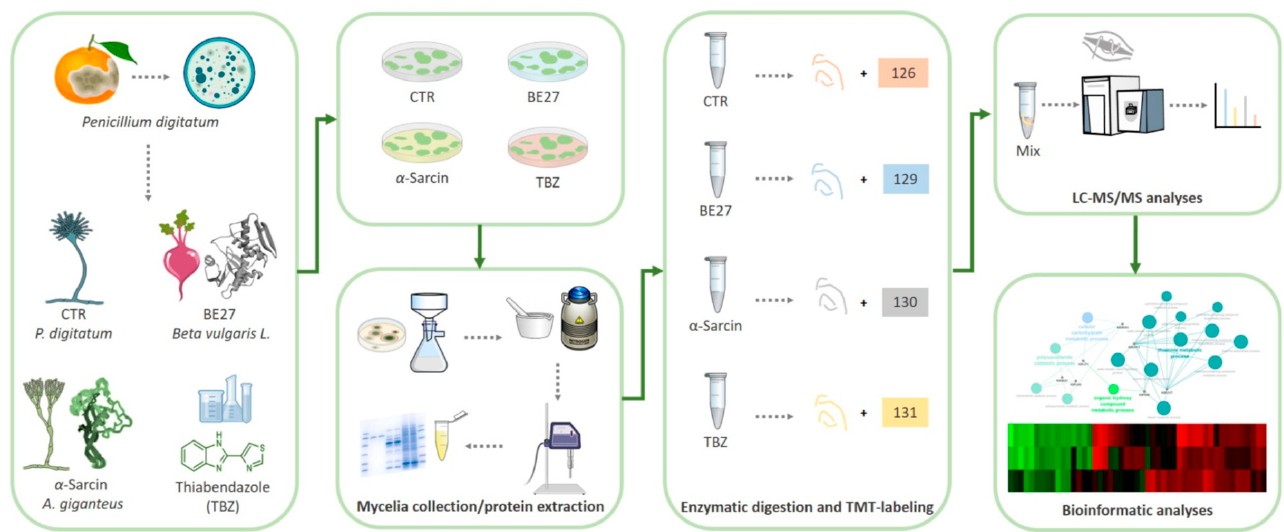
Figure 2. Schematic workflow applied for proteomic analysis of P. digitatum treated with fungi- cide compounds (i.e., α -sarcin, BE27 and TBZ). Following treatments, mycelia were collected and grounded in a ceramic mortar with liquid nitrogen. For Tandem Mass Tag (TMT) isobaric labelling, proteins extracted by sonication were digested into peptides and labelled with TMT isobaric stable isotope tags. After sample mixing, peptides were analysed by LC-ESI-MS/MS. In MS1, the peptides appear as a single precursor. When fragmented during MS2, in addition to the normal fragment ions, the reporter regions dissociated to produce ion signals, which provided accurate quantitative information regarding the relative amount of the peptide in the